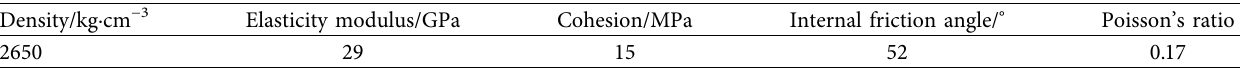
Figure 10: Numerical calculation model of support scheme: (a) bolt-cable-shotcreting support and (b) bolt-cable-shotcreting sup- port +reinforced concrete wall Table 1: Numerical calculation parameters of reinforced concrete wall brickwork.